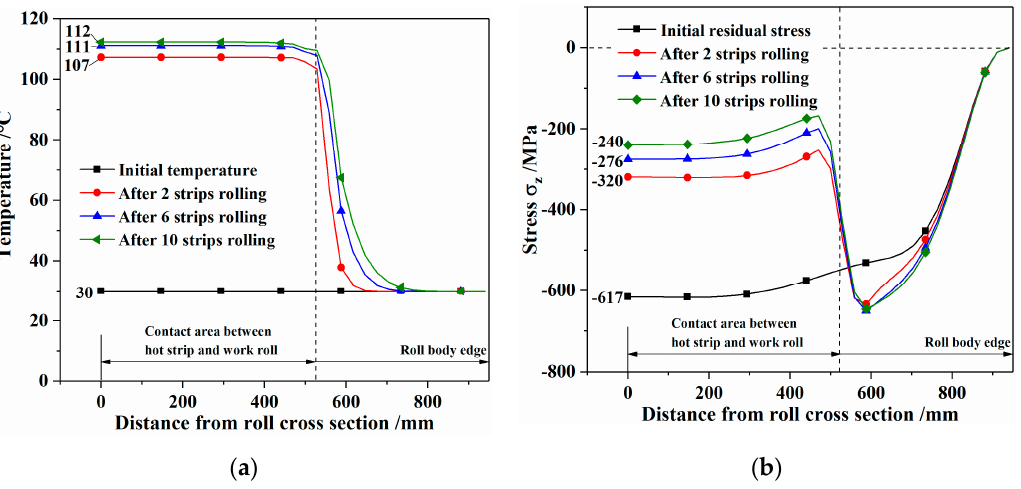
Figure 6. Distributions of temperature and thermal stress considering the initial residual stress at the roll surface along the longitudinal direction of the roll body: ( a ) temperatures after different rolling times; ( b ) thermal stresses after different rolling